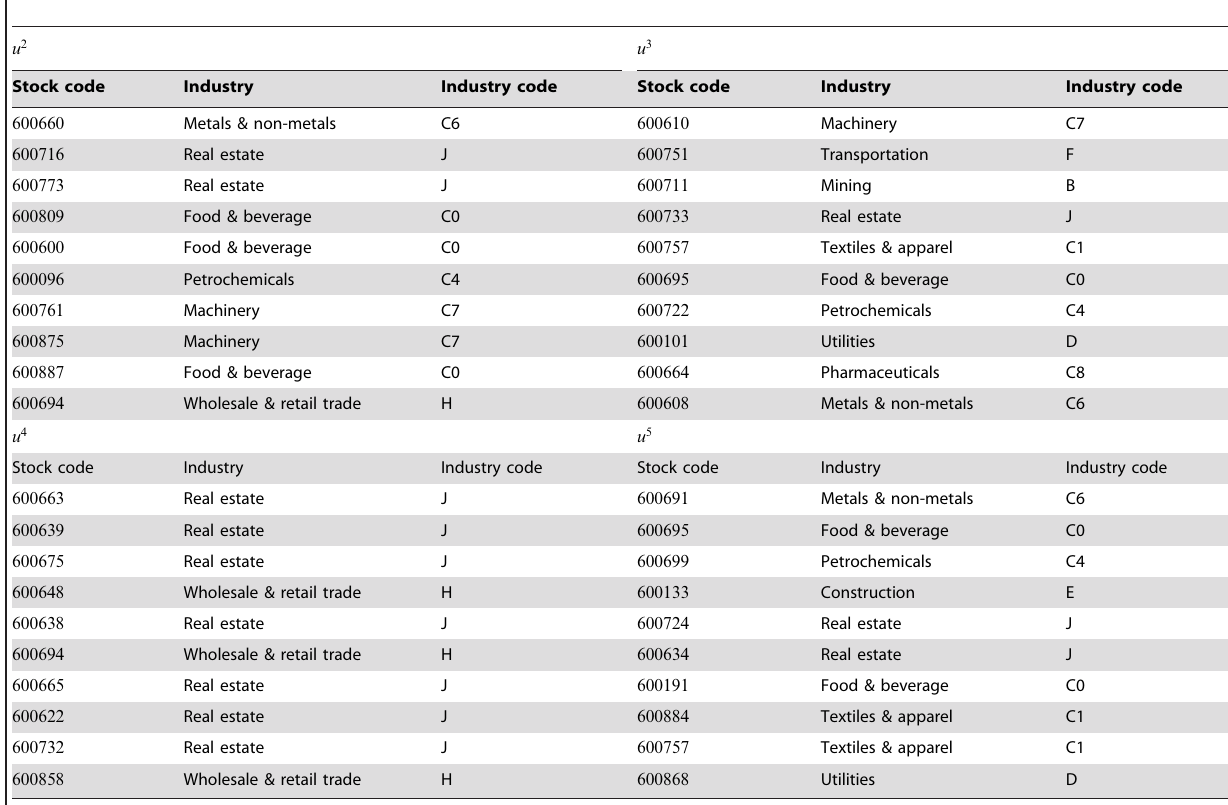
Table 4. Largest ten components of deviating eigenvectors in period from 25/12/2006 to 13/01/2009.